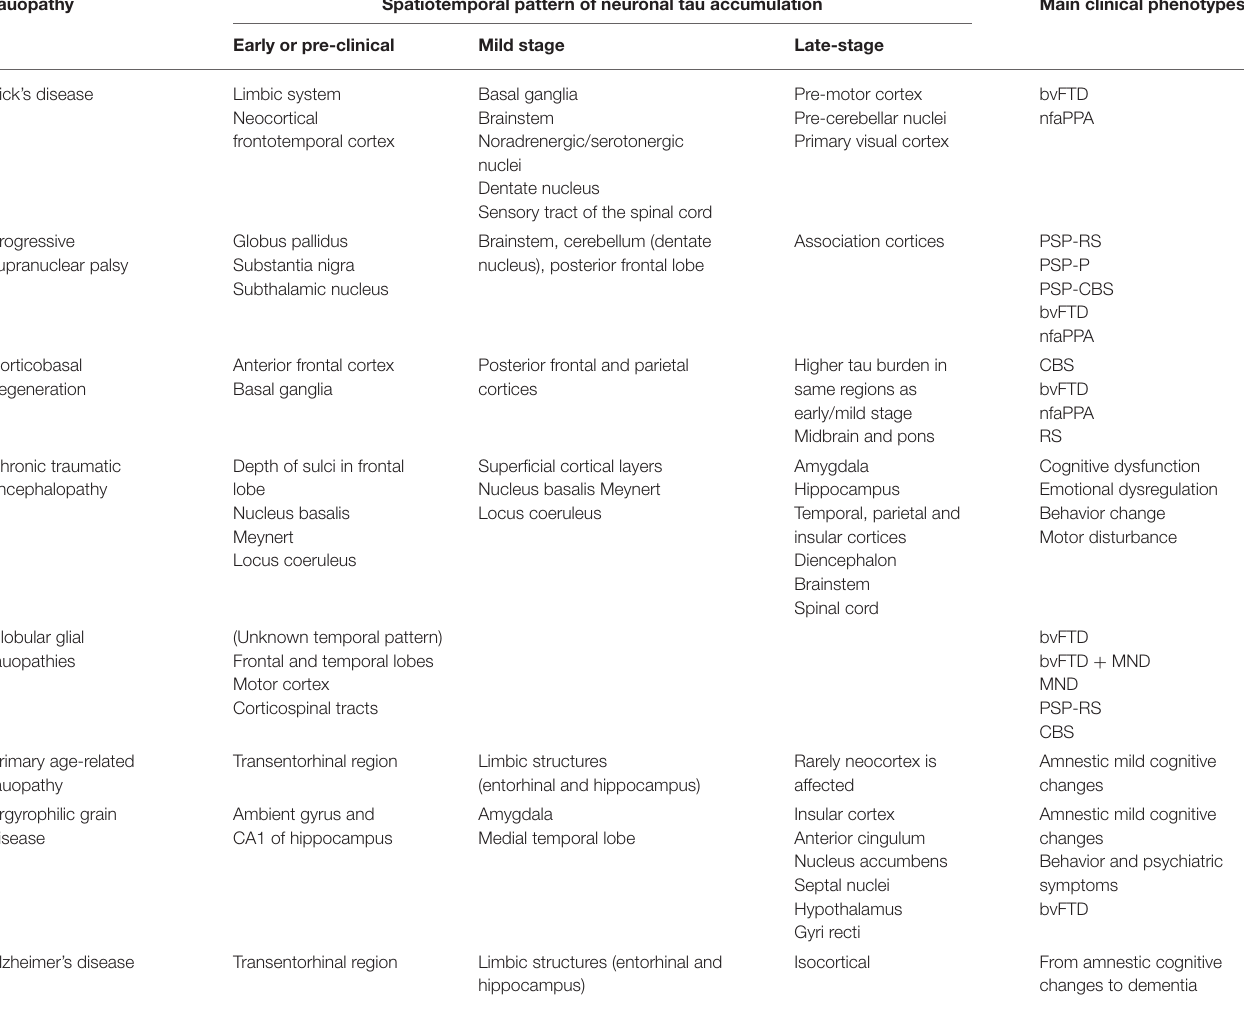
TABLE 2 | Spatiotemporal pattern of accumulation of